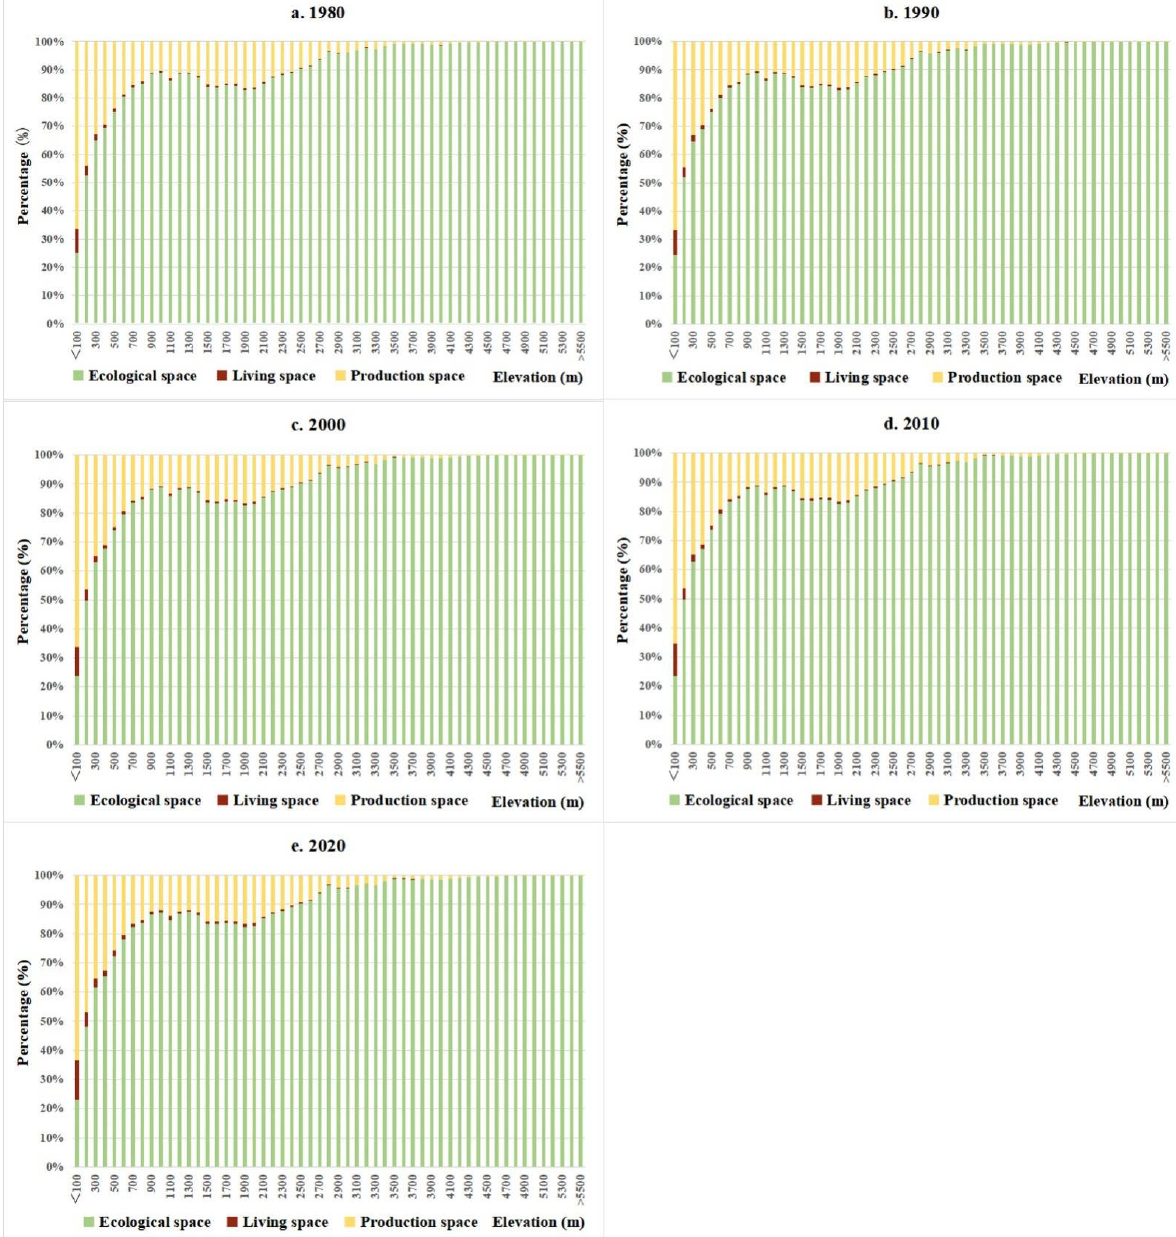
Figure 4. Changes in the proportion of PLES in different elevations in China from 1980–2020.